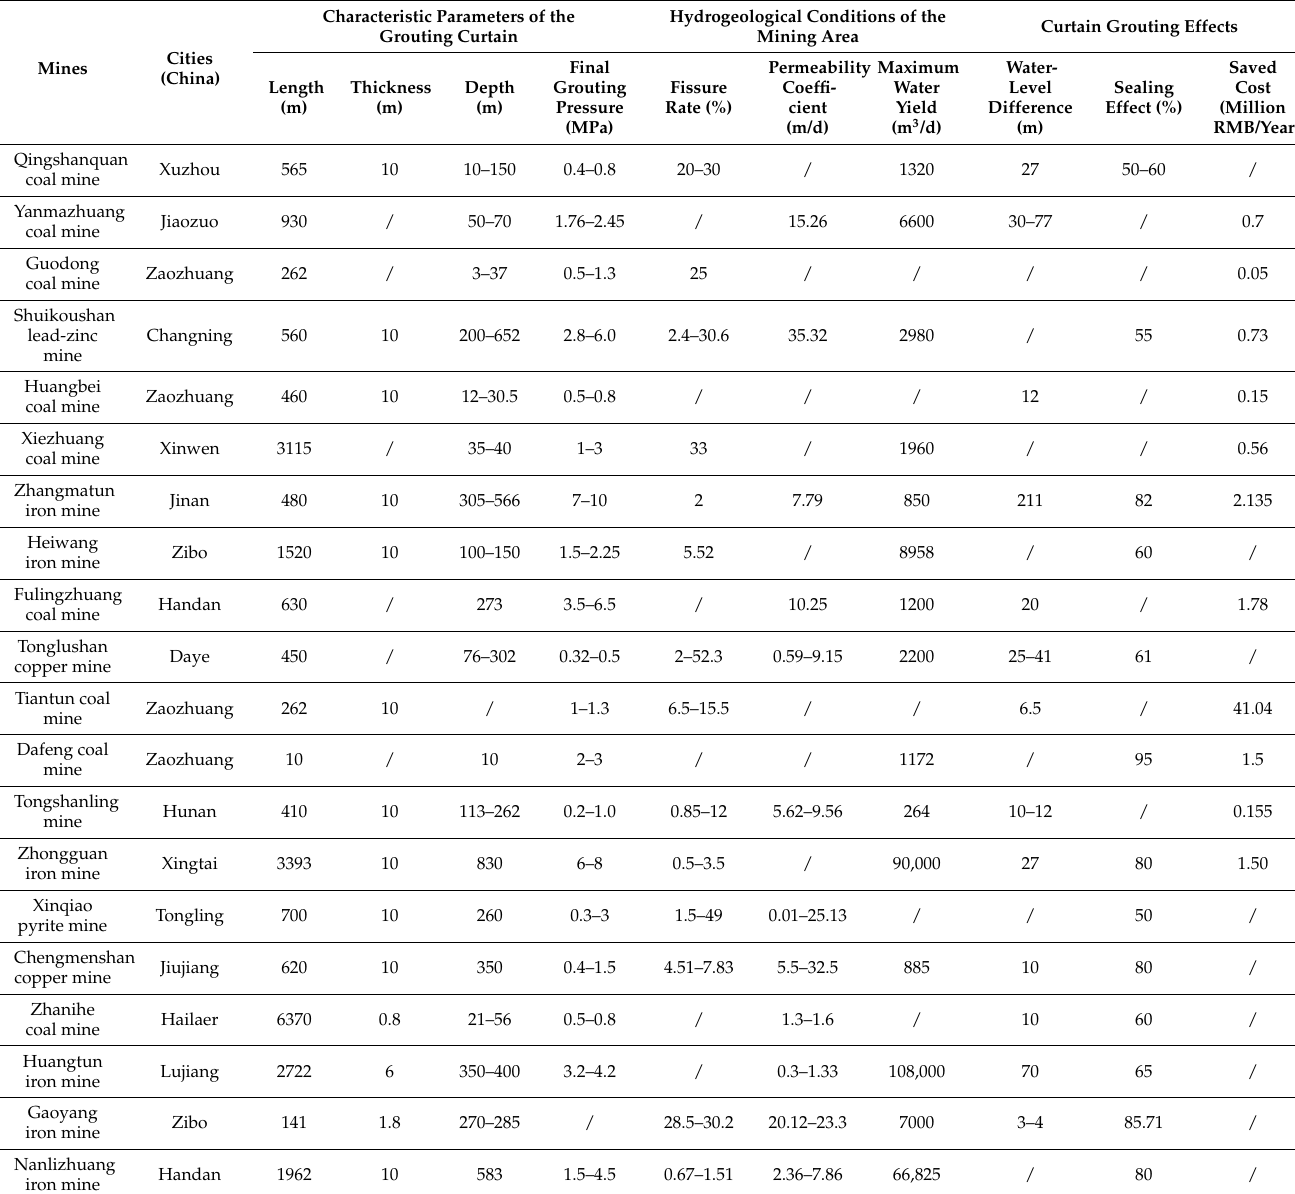
Table 1. Typical cases of using grouting curtain technology to cut off regional groundwater flow in China since the 1960s